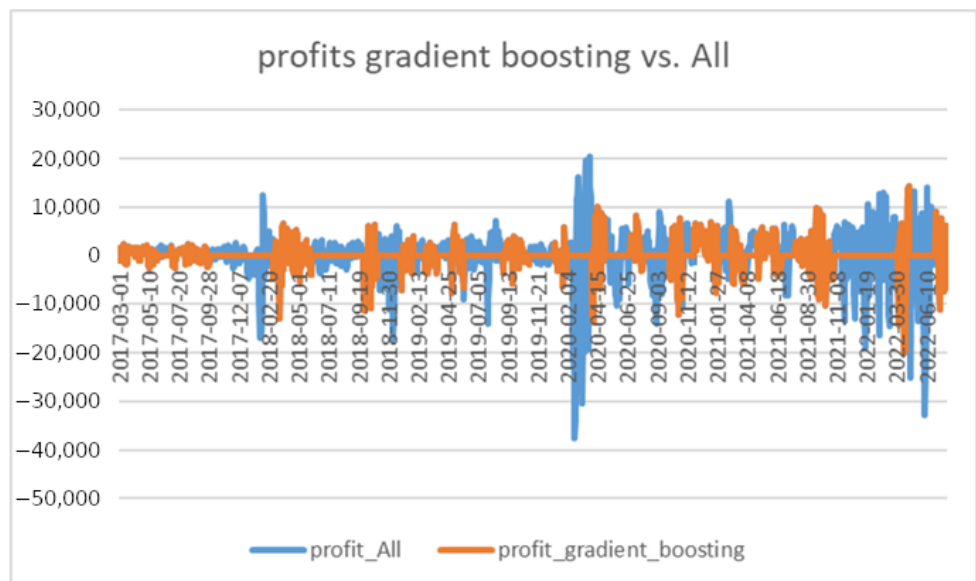
Figure 12. Distribution of profits for the “All-strategy” (blue) and for the “gradient-boosting strat- egy”